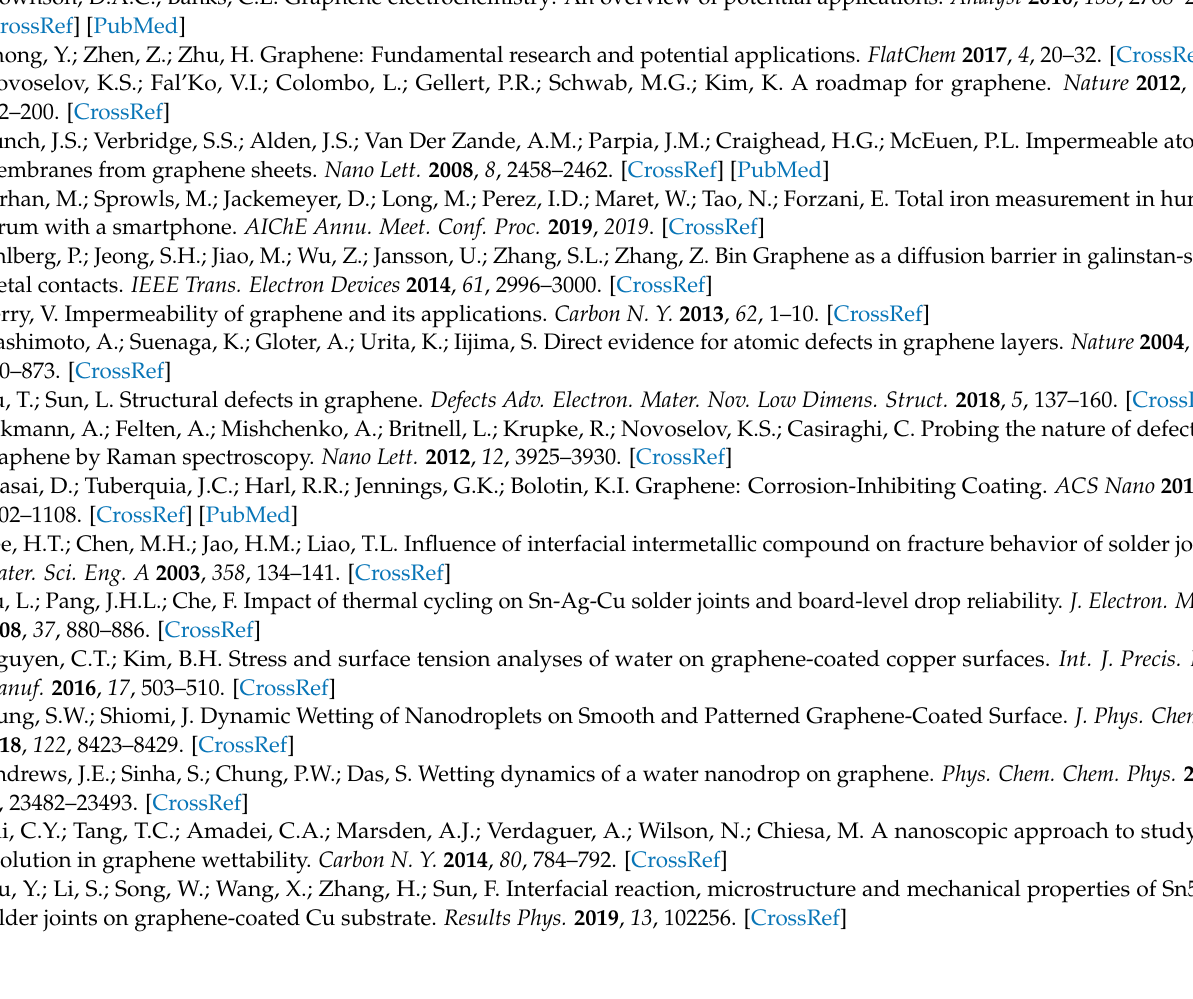
pairs. Figure S3A Comparison of spreading area between three different substrate variants. Figure S3B Spreading coefficient corresponds to the height of Ag droplet after wetting completed. Figure S4A. A graph abundance of VC types present in one variant for three considered substrate variants Gn, Cu/Gn and Cu/Gn def . Figure S4B. A graph abundance of VC types for Ag atoms adsorbed Cu/Gn def and formed an AgCu alloy after reactive wetting is over. Figure S5 Comparison of VC types abundance between three substrate variants and liquid Ag